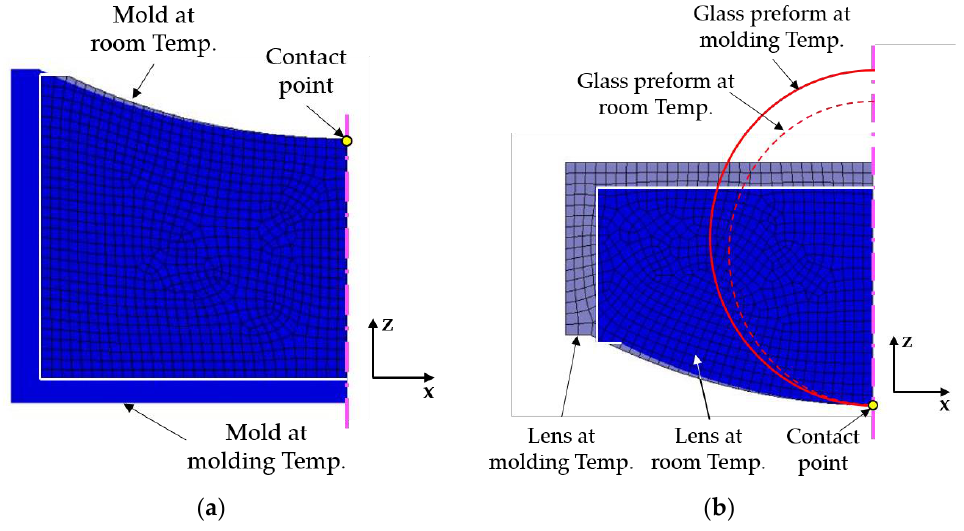
Figure 2. Schematic diagram of expansion and contraction in the precision glass molding (PGM) process. ( a ) Lower mold and ( b ) lens.